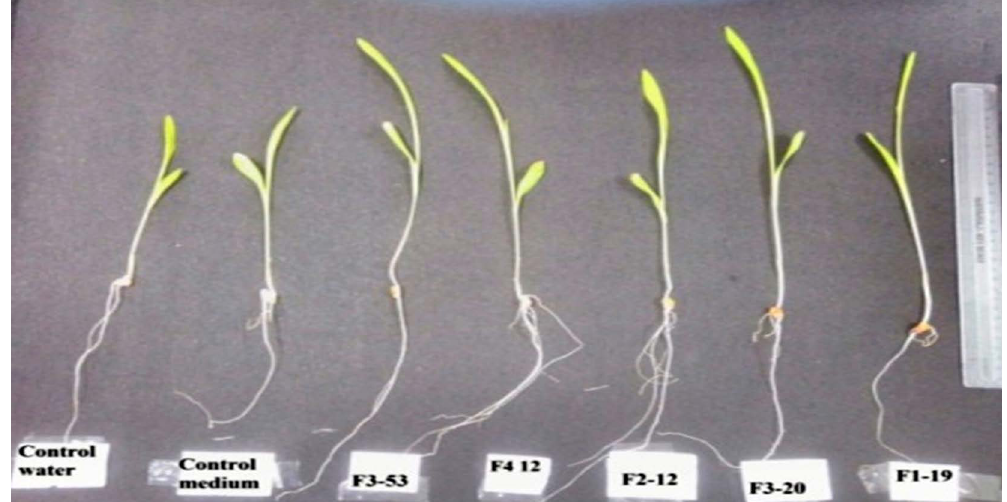
Fig. 1. Observation of paper towel